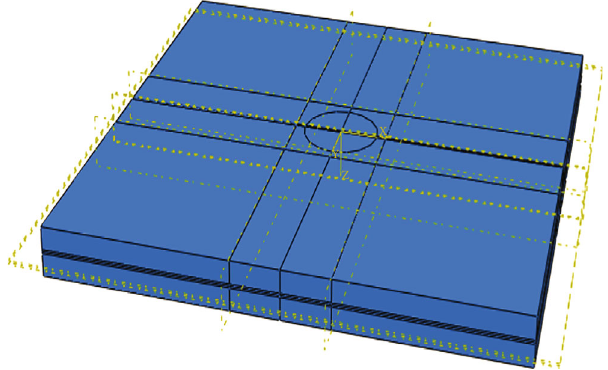
Figure 4: The assembled fi nite element